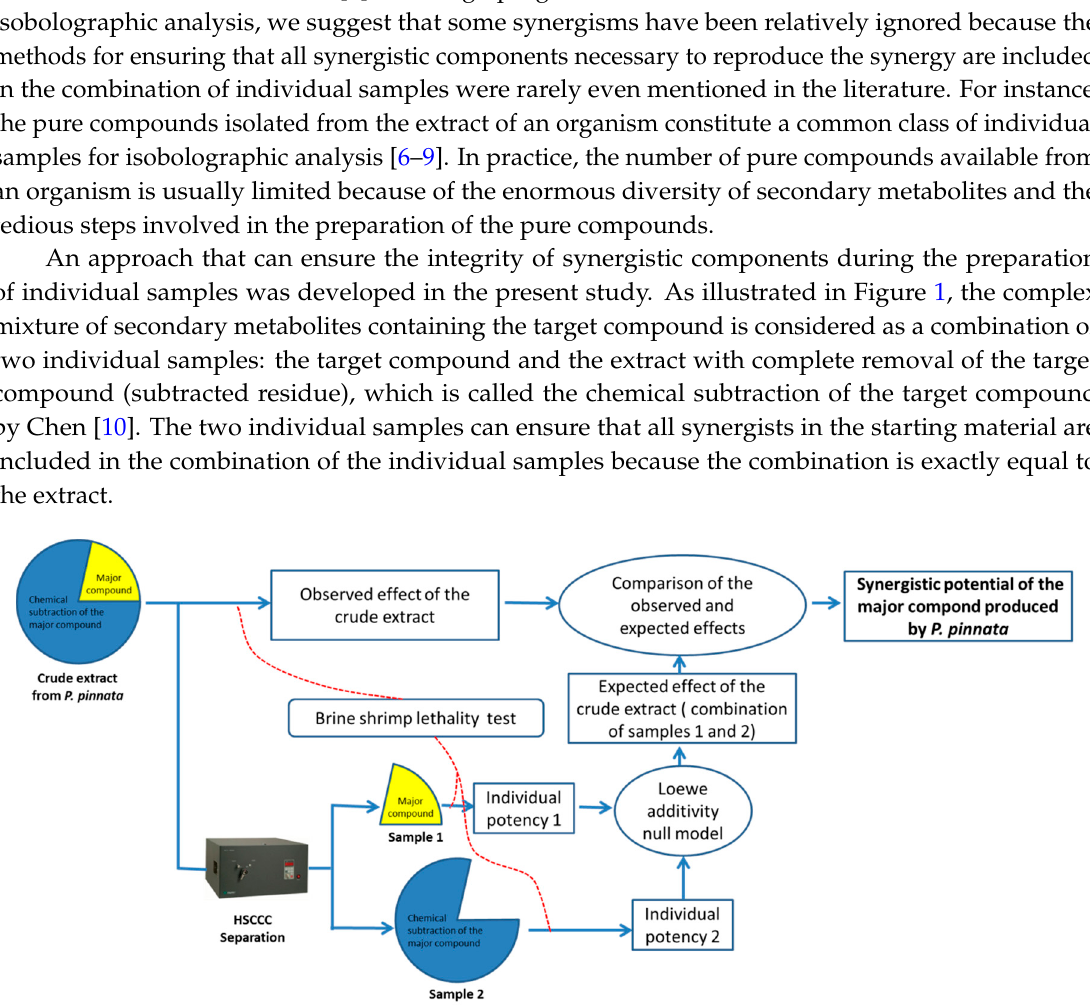
Figure 1. General workflow for the determination of the synergistic potential of a major compound produced by P. pinnata.